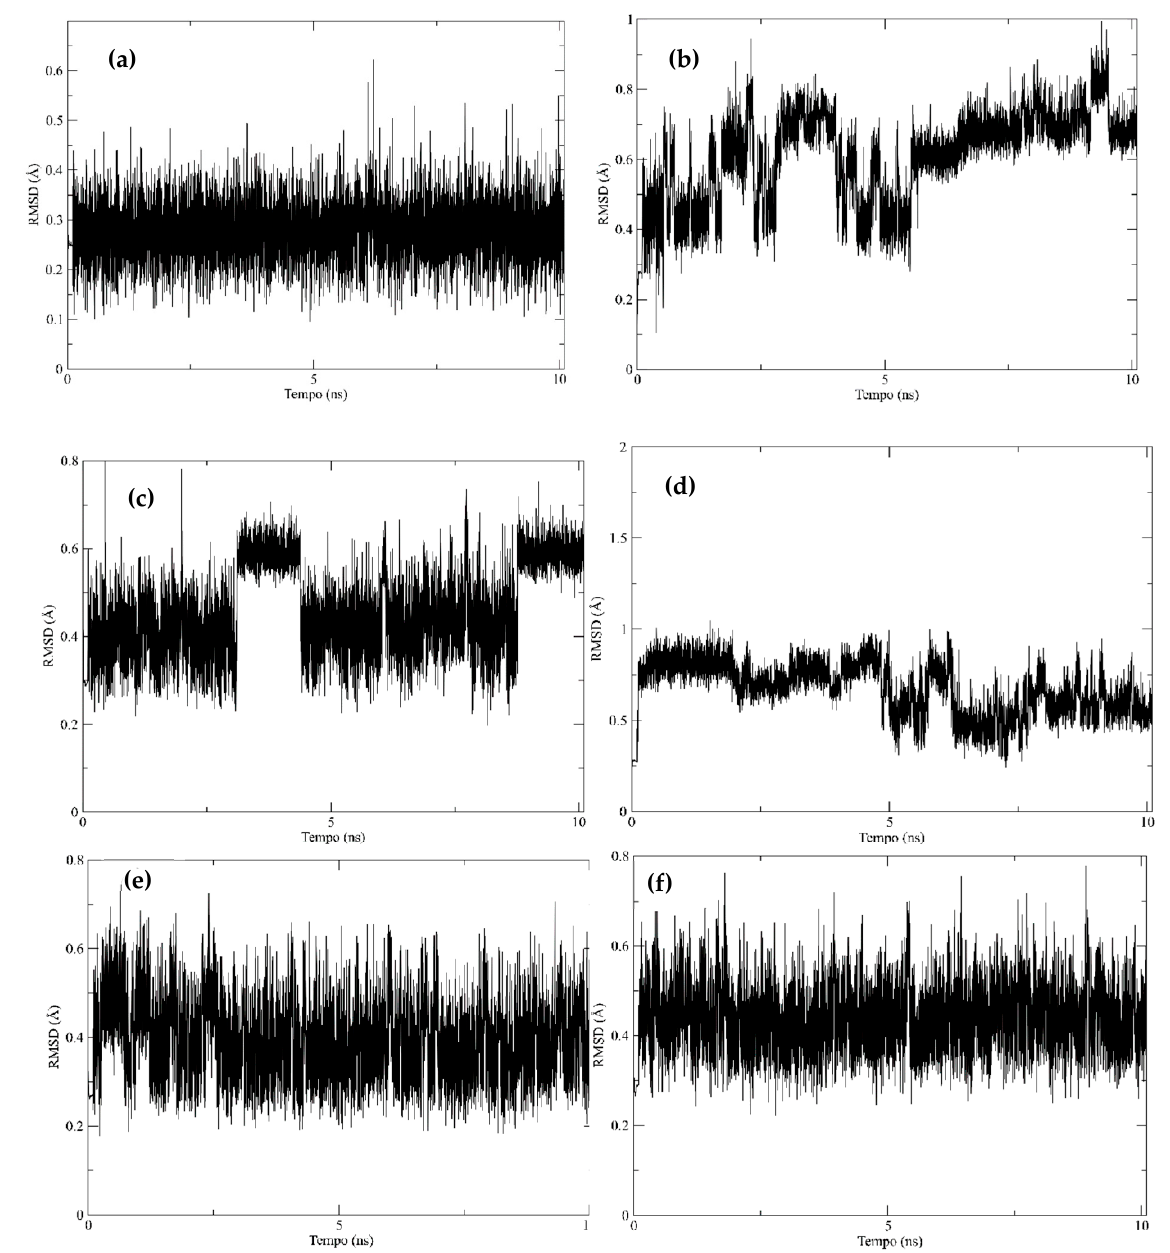
Figure 4. Root Mean Square Deviation ( RMSD ) for the initial conformation of the complexes versus the simulation time (nanoseconds) in the equilibration step. ( a ) Octanoic acid; ( b ) Decanoic acid; ( c ) Dodecanoic acid; ( d ) Tetradecanoic acid; ( e ) Hexadecanoic acid; ( f ) cis -9-octadecenoic acid.